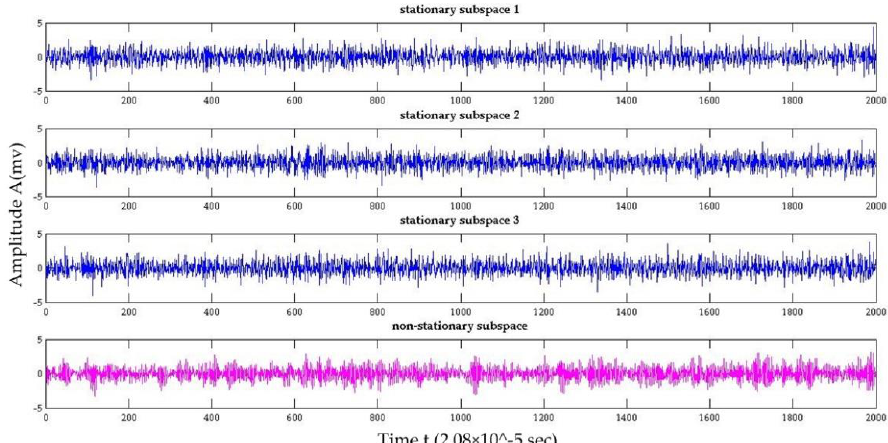
Figure 6. SSA results of mild wear tool sample.